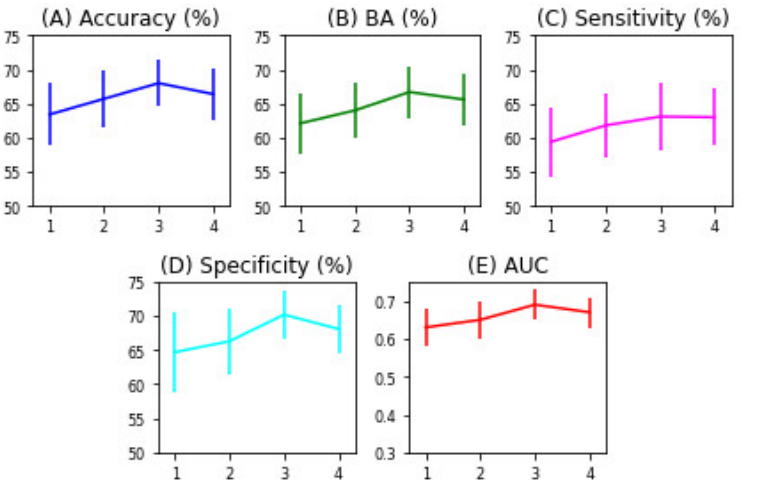
Figure 5. The model performance of the graph convolutional network model using different numbers of graph convolutional layers. The x-axis represents the number of graph convolutional layers, while the y-axis indicates the model performance. ( A ) Accuracy. ( B ) Balanced accuracy (BA). ( C ) Sensitivity. ( D ) Specificity. ( E ) Area under the receiver operating characteristic curve (AUC).